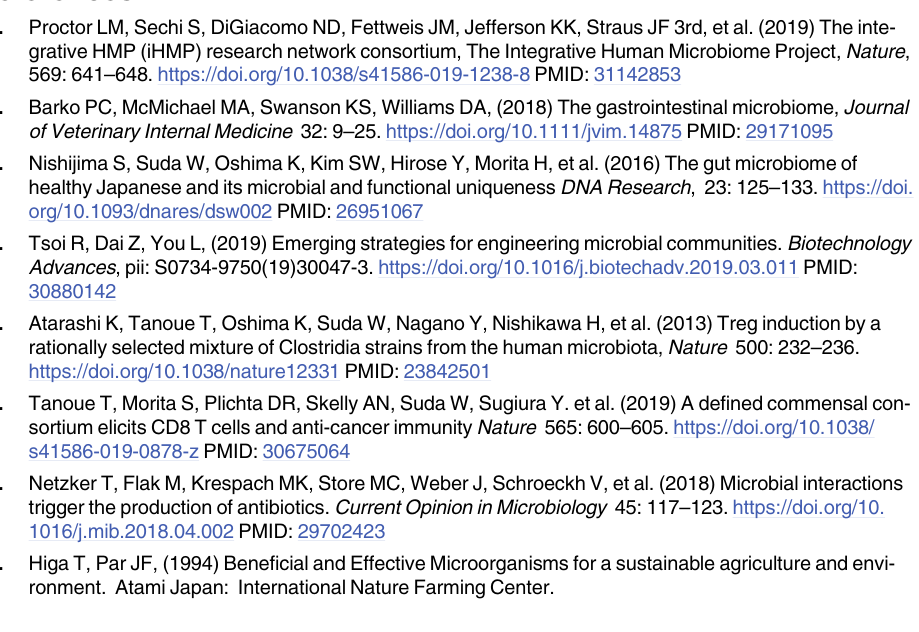
S2 Fig. Column chromatography of water-soluble fraction. Two hundred g of dried water- soluble fraction were dissolved in 10 mL of water-methanol (1:4) mixture, and the solution was filtered through filter paper to give the filtrate and the insoluble (31.5 mg). The filtrate was subjected to preparative HPLC (column, JAIGEL-GS310 (20 mm x 500 mm, Japan Analytical Industry, Co. Ltd.). The column was eluted with a mixture of water-methanol (1:4) to give five fractions. (TIF) S3 Fig. Energy Dispersive X-ray (EDX) spectroscopy. The downward arrows point to signals of Mg and K. Other signals are from the background. (TIF) S4 Fig. Scanning electron micrograph of insoluble residue after autoclave treatment. Note the exposed mesh-like structures. (TIF) S1 File.